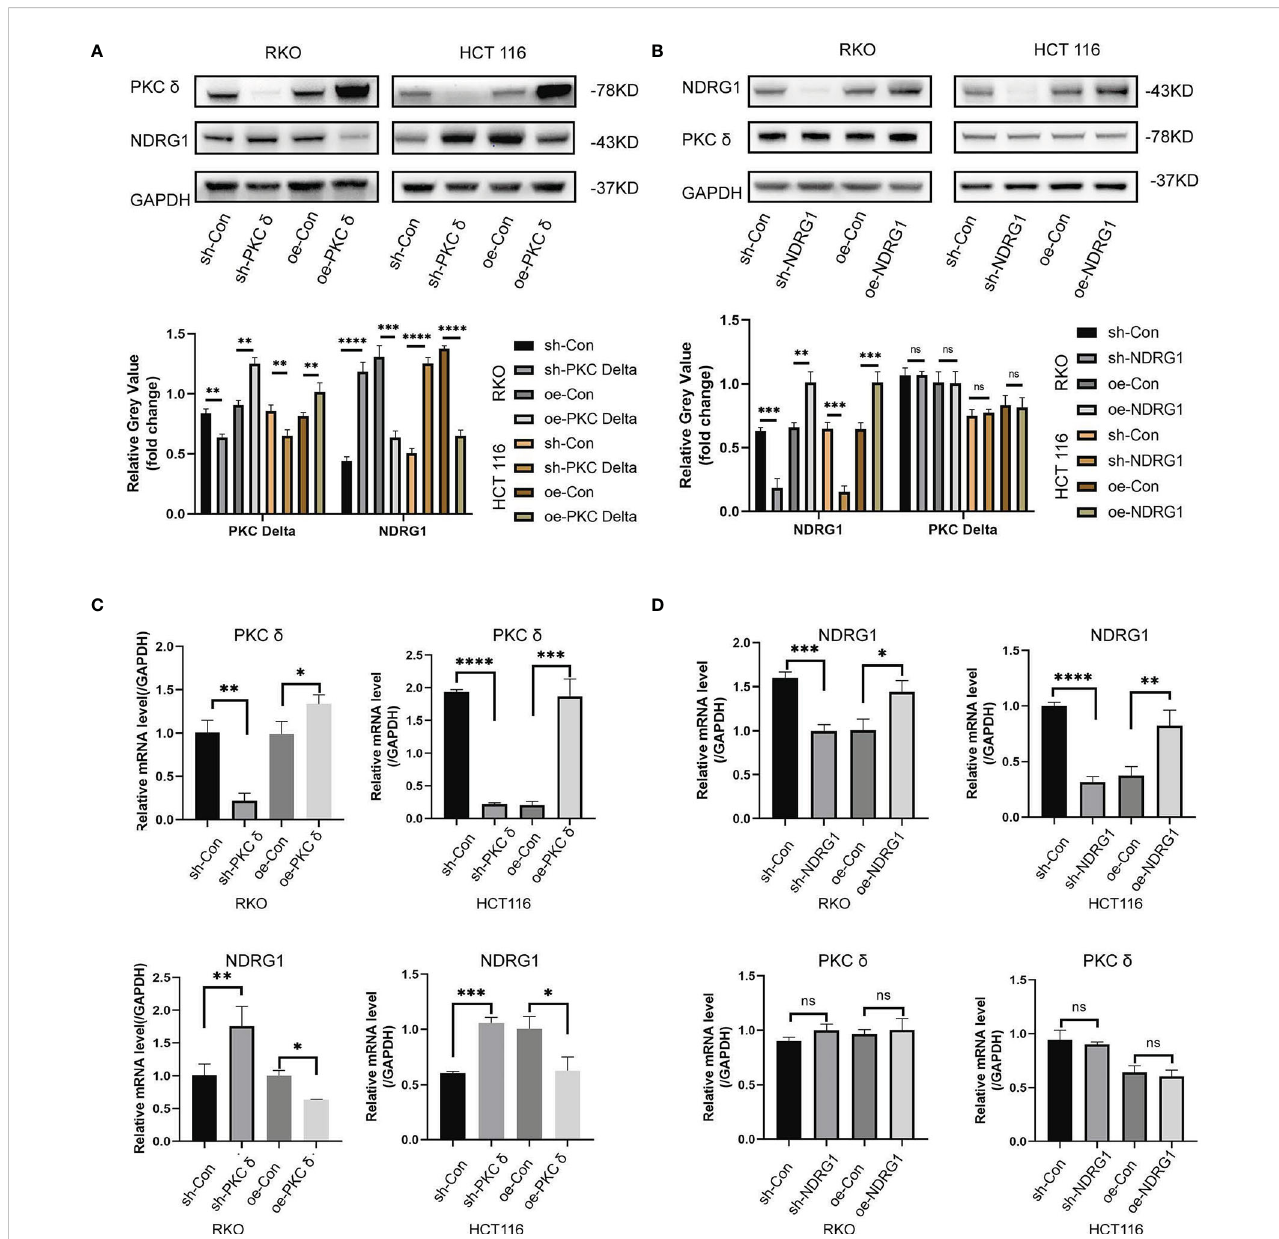
FIGURE 6 PKC d inhibits NDRG1 transcription and protein expression (A) Western blot results showed that the expression of NDRG1 was signi fi cantly down- regulated when overexpressing PKC d , and up-regulated when knocking-down PKC d in RKO and HCT116 cells. (B) No signi fi cant change was found in the expression of PKC d when NDRG1 overexpression or knocking down in RKO and HCT116 cells, determined by Western blots. (C) The level of NDRG1 was signi fi cantly down-regulated when overexpressing PKC d , and up-regulated when knocking-down PKC d in RKO and HCT116 cells, determined by qPCR. (D) No signi fi cant change was found in the level of PKC d when NDRG1 overexpression or knocking-down in RKO and HCT116 cells, determined by qPCR. *p < 0.05, **p < 0.01, ***p < 0.001, ****p < 0.0001. ns, no signi fi